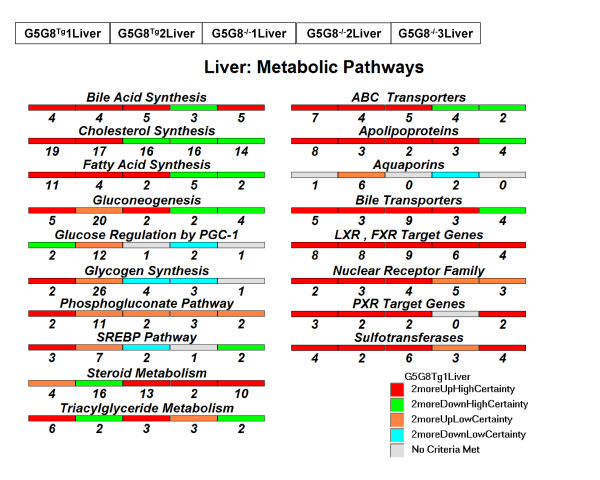
An example of WSCP files in which multiple microarray datasets were analyzed simultaneously. A WSCP file that included a collection of metabolic pathways and gene families with relevance to lipid and glucose metabolism was analyzed using data from the five different microarray datasets (see Additional file 11 for description of material and data preparation). Pooled hepatic mRNA isolated from two sets of G5G8Tg mice (G5G8Tg1Liver, G5G8Tg2Liver) and three sets of G5G8 knockout mice (G5G8-/-1Liver, G5G8-/-2Liver, G5G8-/-3Liver) were hybridized to Affymetrix chips. Each pathway tag is divided into boxes that are tandemly arrayed in the same order as shown at the top of the figure. Once the data is loaded from each of the experiments, the boxes are colored according to the criteria set by the user. The numbers displayed next to the pathway tags (or divided boxes) are numbers of genes matched with pathway criteria-based gene criteria. (Note: if a single CRI is loaded, the whole pathway tag will be colored by this CRI).